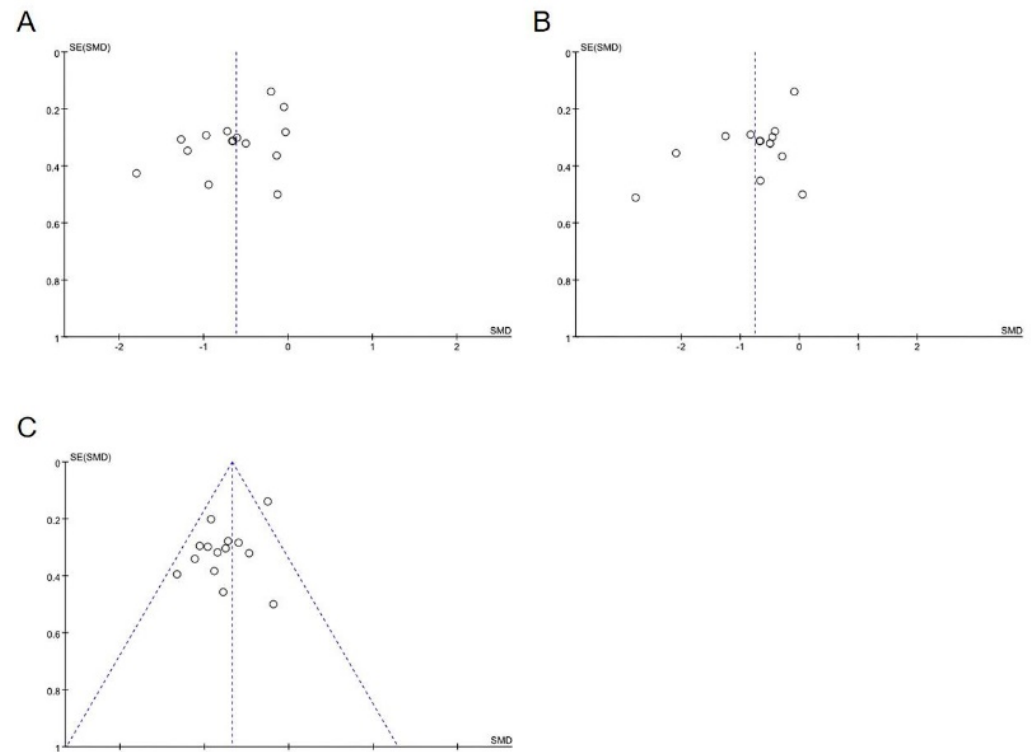
Figure 7. Funnel plots showing a possible publication bias favoring the positive studies on outcomes of the WOMAC/KOOS score. ( A ) Funnel plots of the WOMAC/KOOS pain score. ( B ) Funnel plots of the WOMAC/KOOS stiffness score. ( C ) Funnel plots of the WOMAC/KOOS physical function score.